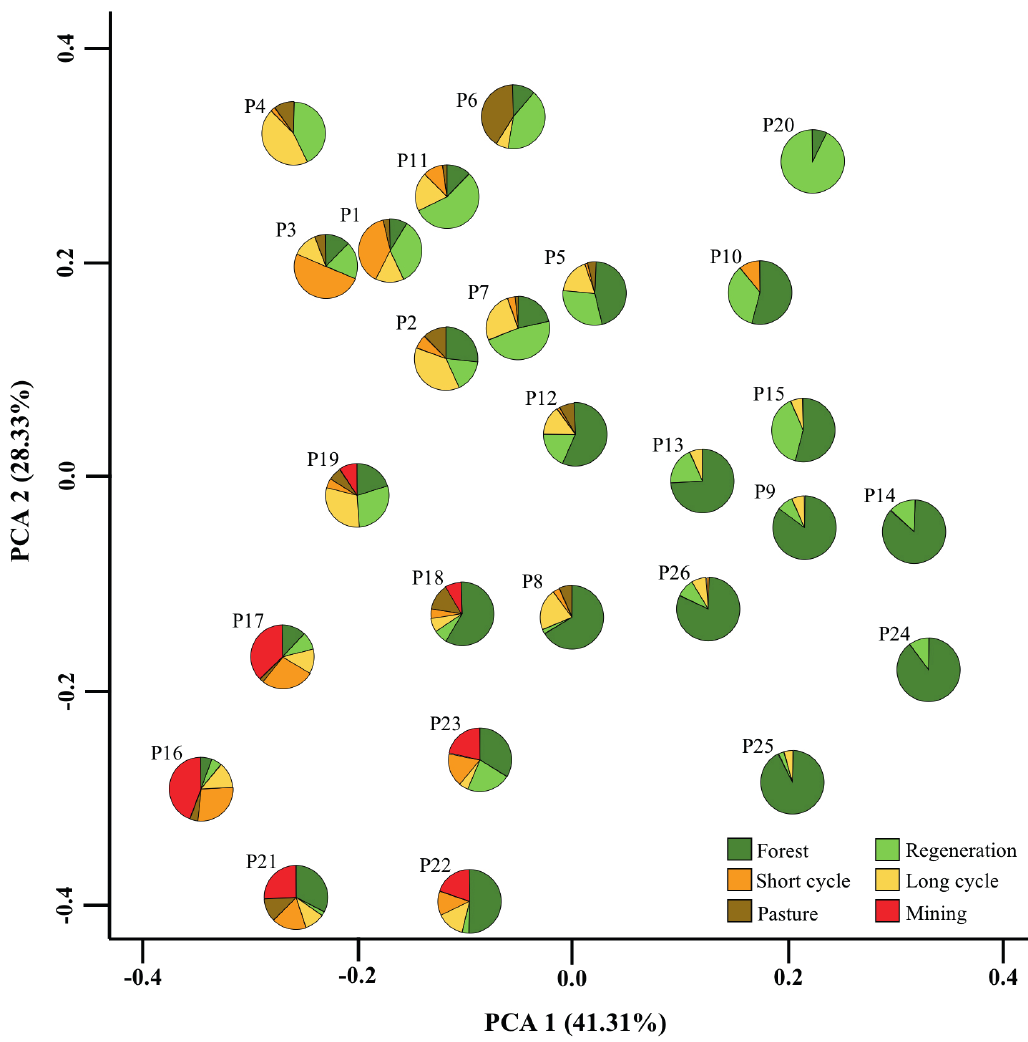
FIGURE 2 | Ordination of the types of land use in the catchment areas of the study streams at the Capim River basin, eastern Amazon.